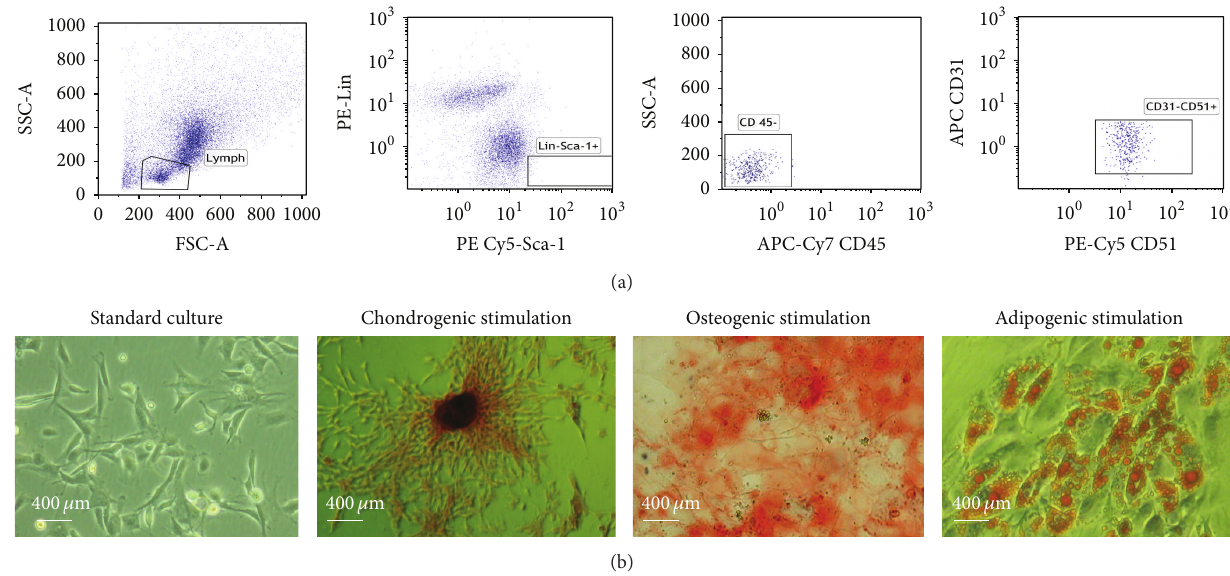
Figure 1: Analysis of MSC (a) phenotypes using flow cytometry. The FACS profile of separated Sca-1 positive and Lin-negative cells demonstrating CD31 negative , CD45 negative , and CD51 positive MSCs (a). (b) Morphology of MSCs cultured in DMEM medium supplemented with 10% of FBS (standard culture) and the results of its chondrogenic, osteogenic, and adipogenic stimulation. For visualization of glycosaminoglycans and calcium deposits specific Safranin O and Alizarin Red staining were used, respectively, while lipid droplets were stained using Oil Red O.